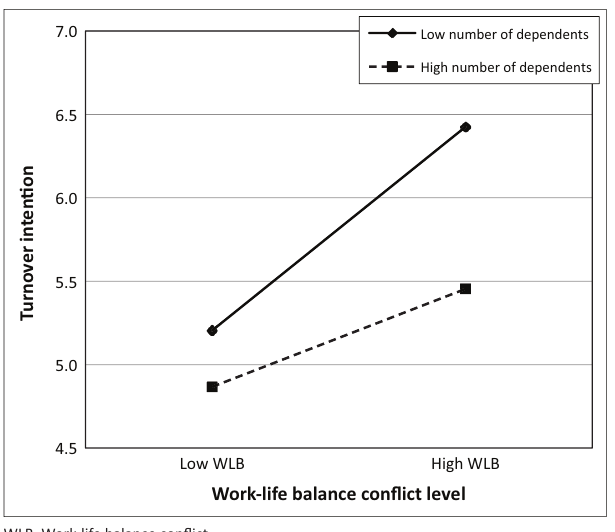
Work-life balance conflict level FIGURE 4: Social support as a moderator of the work-life balance–turnover intention relationship (two-way interaction).